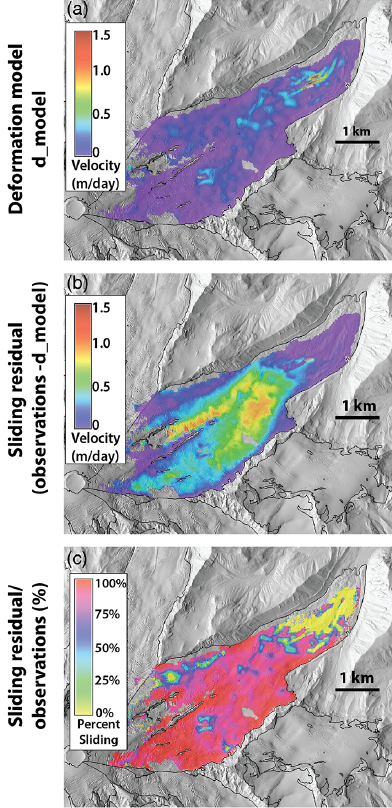
Figure 10. Same as Fig. 9 but for Emmons